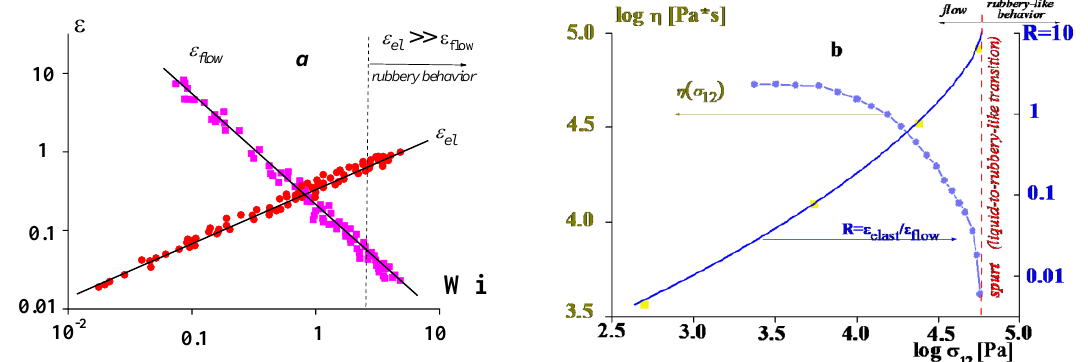
Figure 1. The relationship between fluidity and recoverable deformations in polyisoprene demon- strating the flow-to rubbery state transition, ( a ) and correlation with non-Newtonian flow ( b ). The ratio R is equivalent to the Weissenberg number [10].